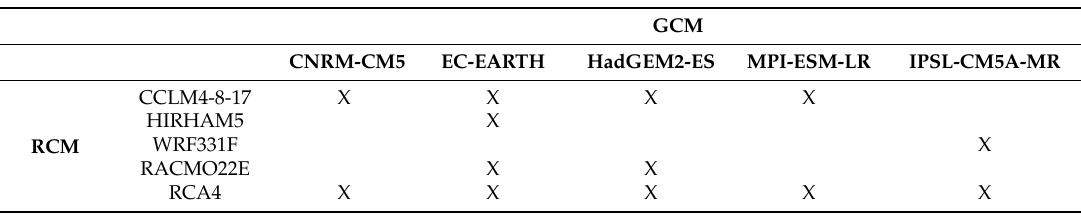
Table 1. EURO-CORDEX ensemble (www.euro-cordex.net), combination of different RCMs and GCMs, adopted in this